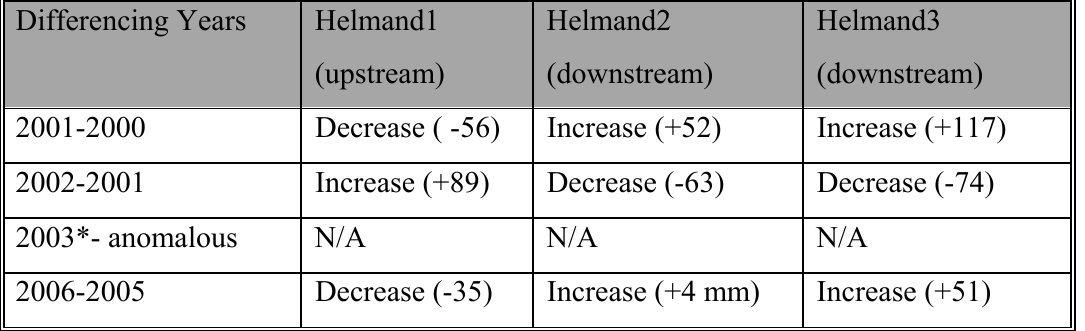
Figure 12. Seasonal ETa (AET) (mm) estimates (2000 – 2005) for all major irrigated areas in the Helmand and Kabul basins. Table 3. Relative water use changes in the three irrigation areas of Helmand basin. Bracketed values are estimated seasonal actual ET (ETa) differences in mm. This table is a partial summary of graphical data presented in Figure